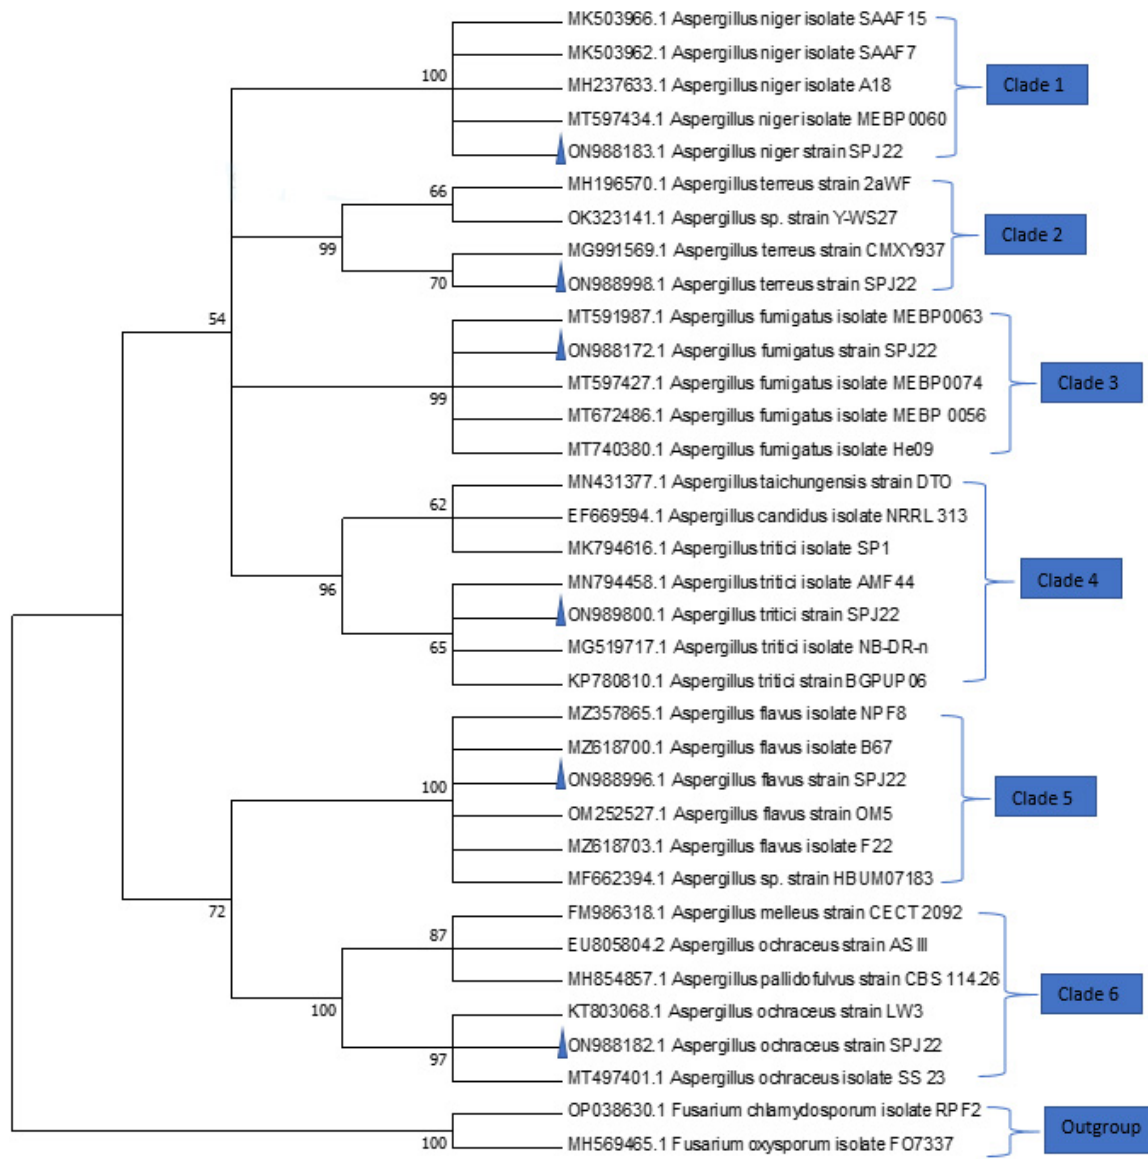
Figure 1. Phylogeny of Aspergillus isolates (taxa names with triangles) from dairy feeds based on ITS-region sequence homology. Numbers within the tree represent the bootstrap values of 1000 rep- licates. The phylogram is rooted (outgroup) with F. chlamydosporum and F. oxysporum.